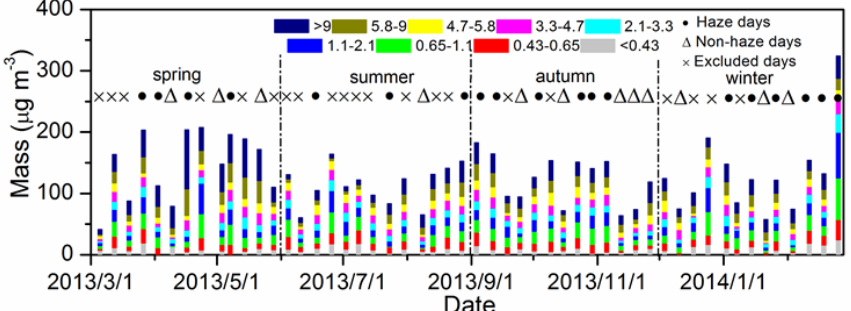
Figure 2. Size-resolved mass concentration (distributions that are marked as solid circle and open triangle denote haze and non-haze days,